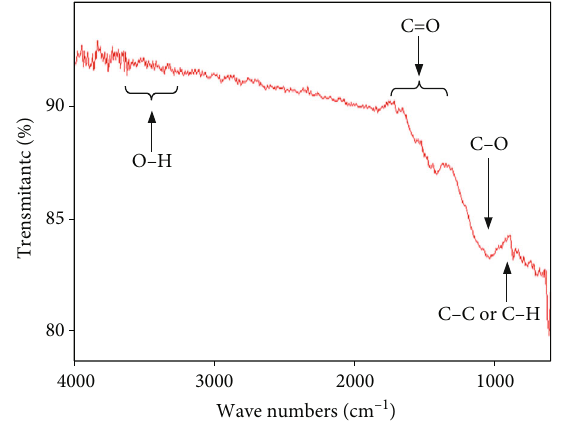
Figure 3: FTIR spectrum after